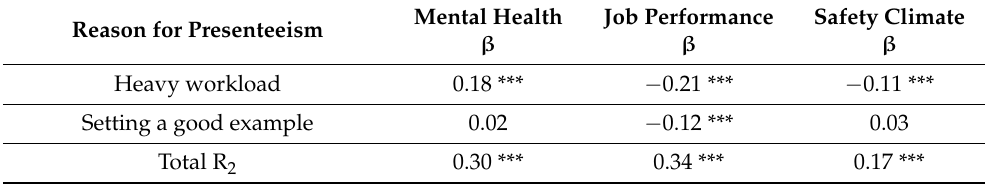
Table 3. Cont. Mental Health Job Performance Safety Climate Reason for Presenteeism β β β Heavy workload 0.18 *** − 0.21 *** − 0.11 *** Setting a good example 0.02 − 0.12 *** 0.03 Total R 2 0.30 *** 0.34